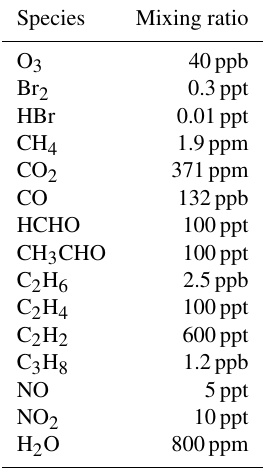
Table 1. Initial atmospheric composition in the 200m boundary layer (ppm is parts per million, ppb is parts per billion, ppt is parts per trillion) (Cao et al., 2014).